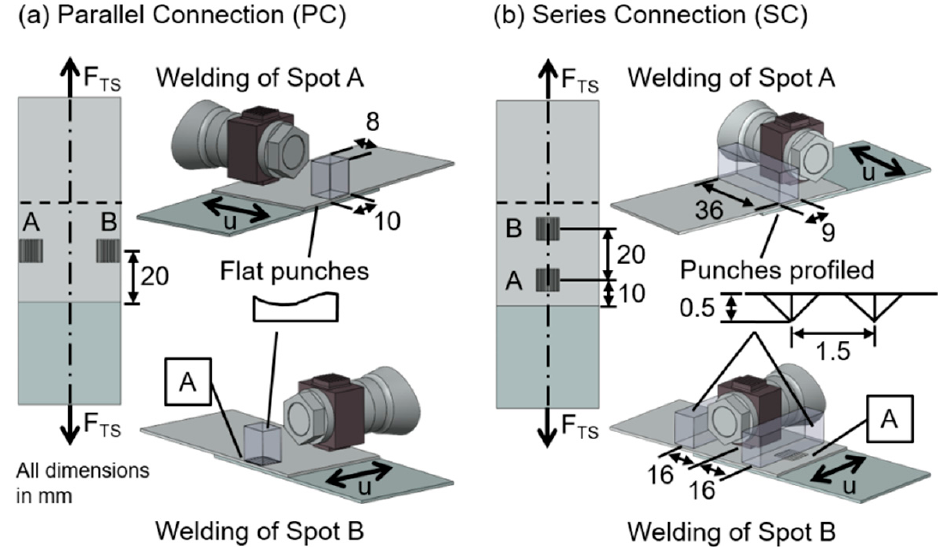
Figure 2. The spot arrangements and schematic illustrations of the sonotrode and the clamping punches being used to weld Spots A and B, in ( a ) parallel and ( b ) series configuration. All dimensions in mm.